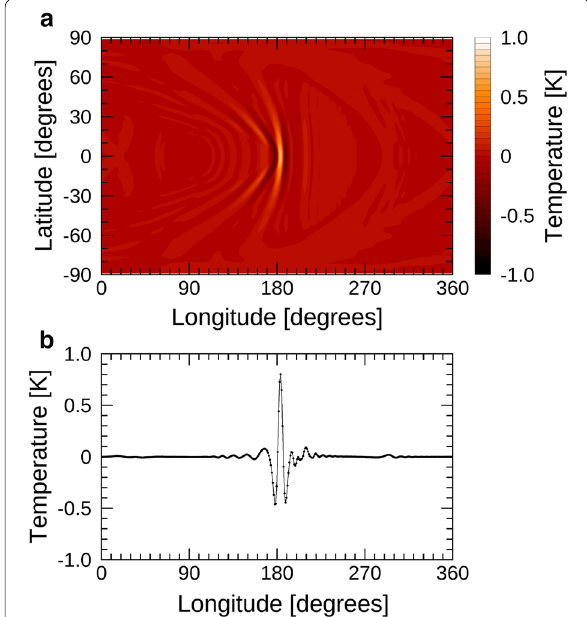
Fig. 4 a Horizontal structure of the temperature disturbance and b longitudinal profile of the temperature disturbance averaged for the 5 5 latitudes of ◦ to ◦ in the nominal case shown in Fig. −